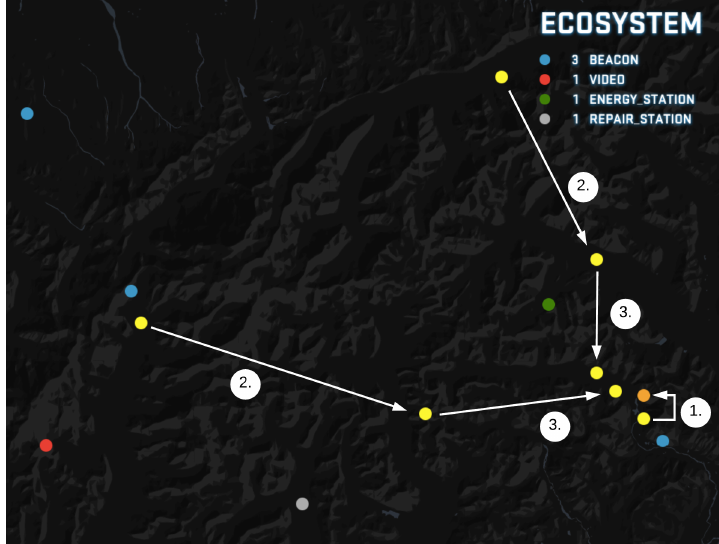
Fig. 1. Search and Rescue Mission. Step 1: One drone detects an object. Step 2: The other drones move towards the tagged location. Step 3: All the drones converge upon the location, concluding the